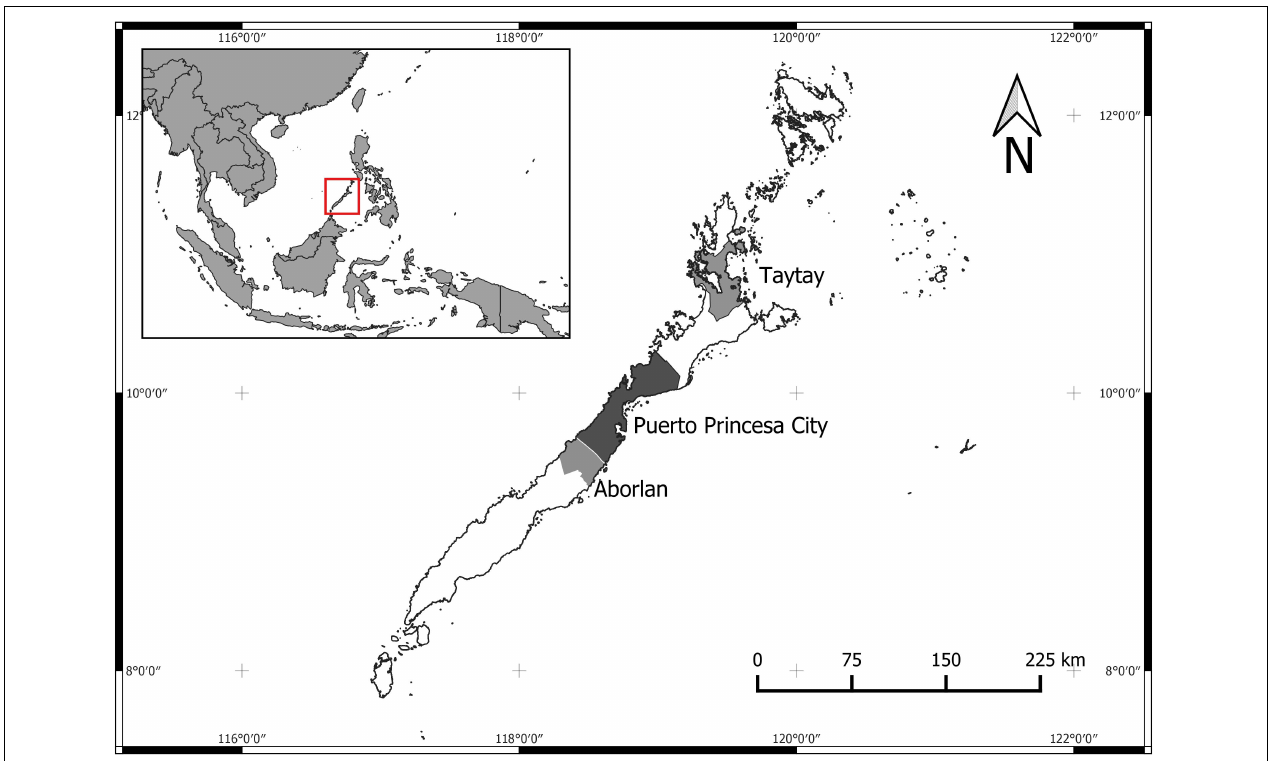
FIGURE 1 | Map showing the province of Palawan, Philippines, and the study areas – the municipalities of Taytay, Aborlan, and Puerto Princesa City. The red square highlights the Palawan island location relative to Southeast